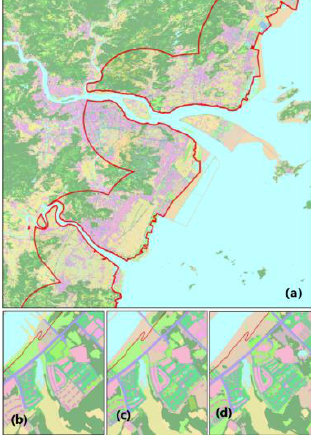
Figure 1. Coastal zone landscape with a 10 km buffer based on high resolution images. The land types are coded as follows: 01, farmland; 03, forest and grassland; 05, buildings; 06, roads; 07, structures; 08 stacked and excavated land; 09, bare land; 10, water areas. (a) (a) Ningde, Fujian in 2019; (b) Danzhou, Hainan in 2015; (c) Danzhou, Hainan in 2016; (d) Danzhou, Hainan in 2017.